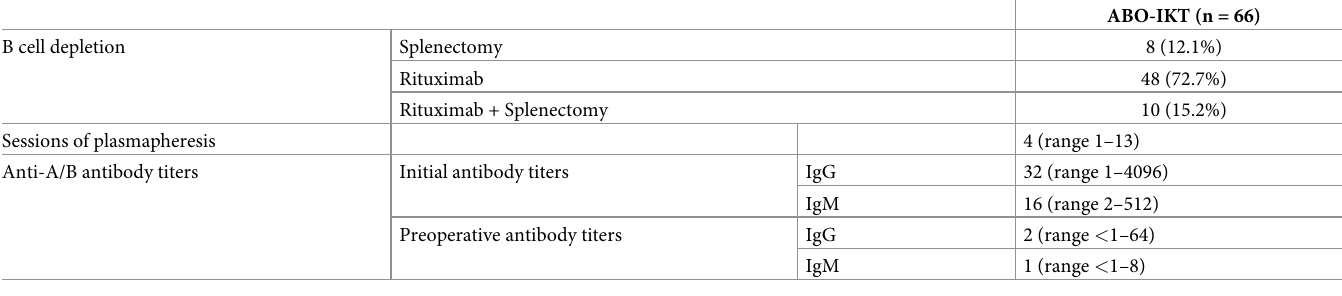
Table 3. Desensitization for ABO-IKT recipients.